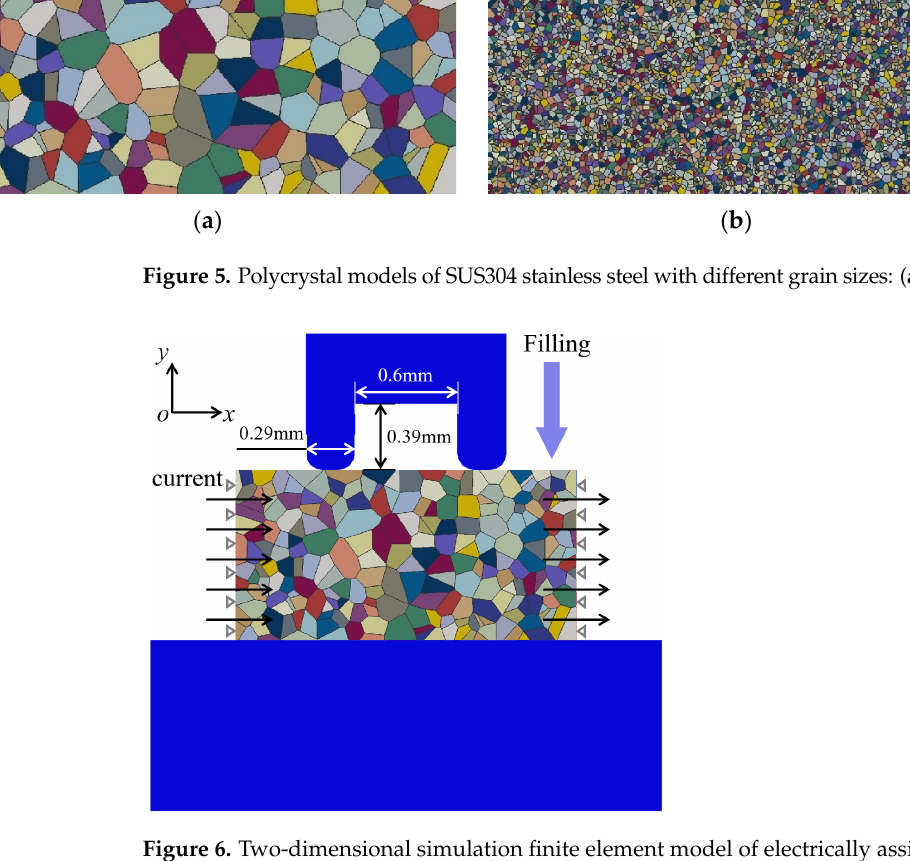
Figure 6. Two ‐ dimensional simulation finite element model of electrically assisted micro ‐ filling.